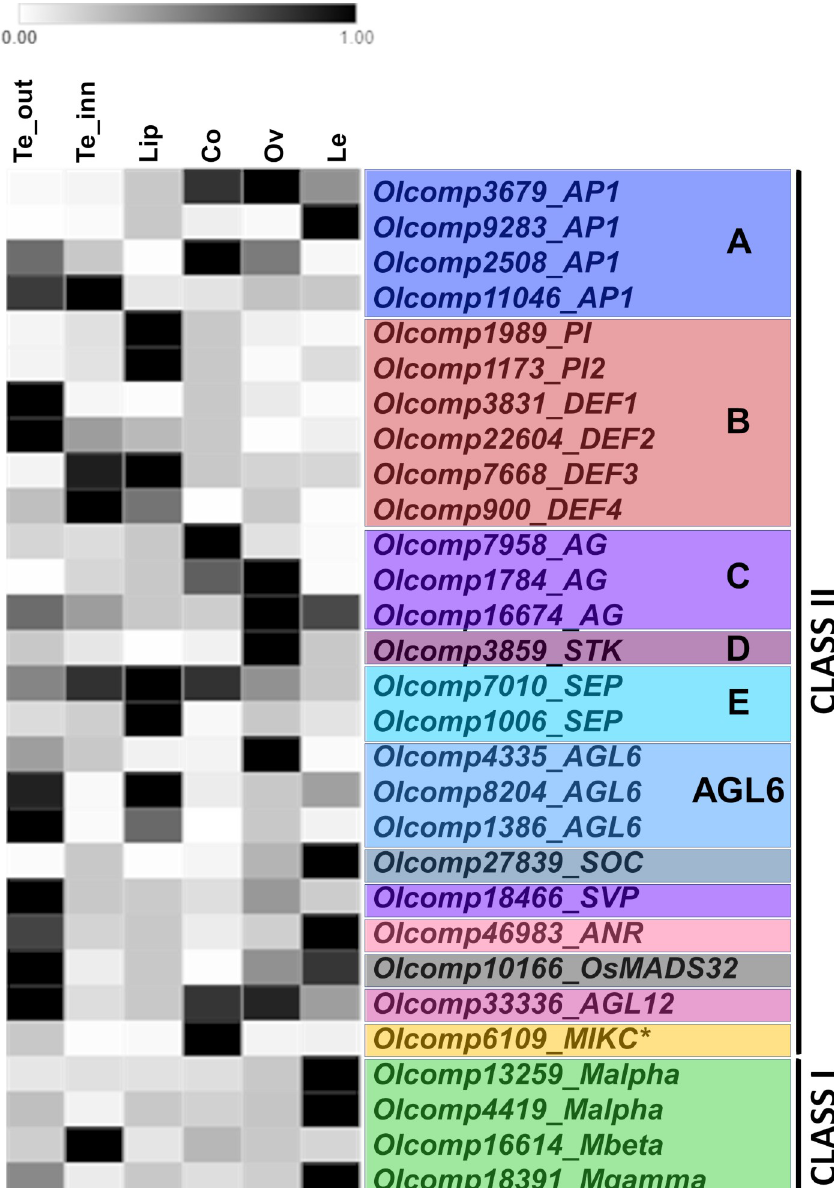
Fig 3. Heatmap of the relative gene expression of the MADS-box genes in the floral tissues of O . italica . The scale for each gene is independent of each other and set to 1 as the highest value. Te_out, outer tepals; Te_inn, lateral inner tepals; Co, column; Ov, ovary; Le,